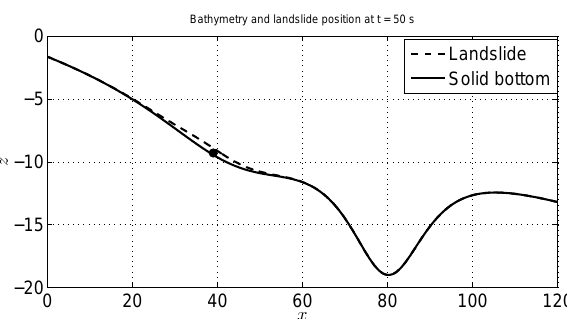
Figure 1. The fixed bathymetry z = h 0 ( x ) and the position of the landslide after Fig. 1. The fixed bathymetry z = h 0 (x) and the position of the land- 50 s . The position of the barycenter is indicated by a black dot. slide after 50s. The position of the barycenter is indicated by a black is only approximate, and in particular, one important effect of surface waves, namely the influence of frequency dispersion is neglected.